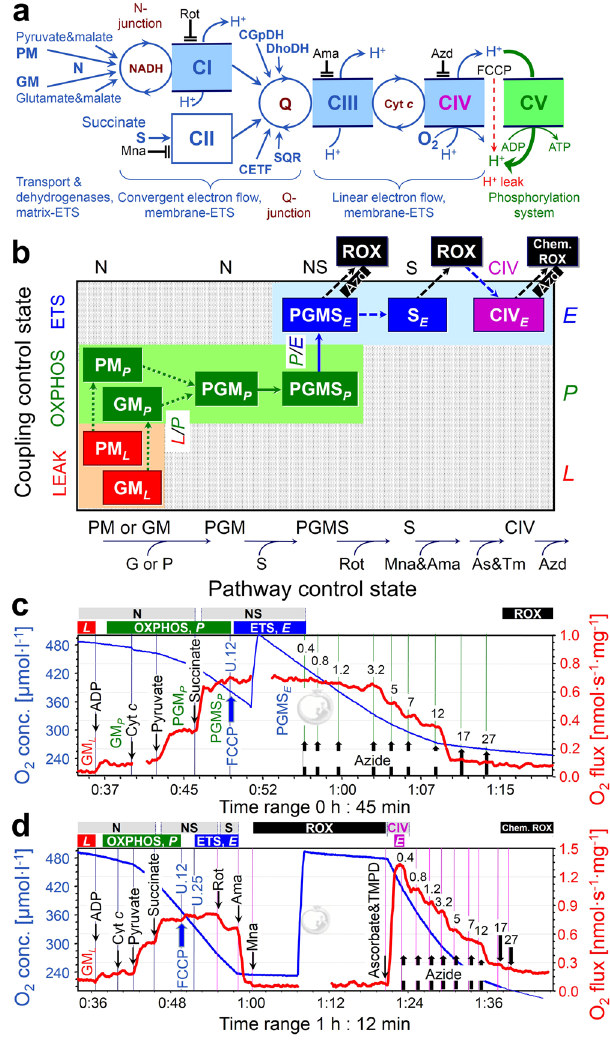
Figure 1. Mitochondrial pathways, substrate-uncoupler-inhibitor-titration (SUIT) protocols and respiration of permeabilized cardiac fibers. ( a ) Schematic representation of the electron transfer system (ETS) coupled to the phosphorylation system (ATP synthase, adenylate translocator and inorganic phosphate transporter). Electron flow from pyruvate&malate (PM) or glutamate&malate (GM) converges at the N-junction (NADH-cycle). Electrons converge at the Q-junction from Complex I (CI, NADH-ubiquinone oxidoreductase), Complex II (CII, succinate-ubiquinone oxidoreductase), glycerophosphate dehydrogenase Complex (CGpDH), electron- transferring flavoprotein Complex (CETF), dihydro-orotate dehydrogenase (DhoDH) 92 , sulfide-ubiquinone oxidoreductase (SQR) 93 , and choline dehydrogenase (not shown), followed by a linear downstream segment through Complexes III (CIII, ubiquinol-cytochrome c oxidoreductase) and CIV (cytochrome c oxidase), to the final electron acceptor oxygen. CI, CIII, and CIV are proton pumps generating an electrochemical potential difference across the inner mt-membrane. Coupling of the phosphorylation system with the ETS allows the proton potential to drive phosphorylation of ADP to ATP (coupled flow). Protonophores such as FCCP uncouple the ETS from ATP production. Rotenone, malonate and antimycin A are specific inhibitors of CI, CII and CIII, respectively, and were sequentially added at saturating concentrations. ( b ) Coupling/pathway control diagram illustrating the two protocols starting with either PM or GM (SUIT 1 and 2), convergent electron flow at the Q-junction in the NADH&succinate (NS) pathway, and azide titrations in the NS-pathway control state or single enzyme step of CIV. As&TM, Ascorbate&TMPD. ( c ) SUIT 2a with azide titration in the NS-pathway control state. ( d ) SUIT 2b with azide titration in the CIV single enzyme step as a basis of threshold